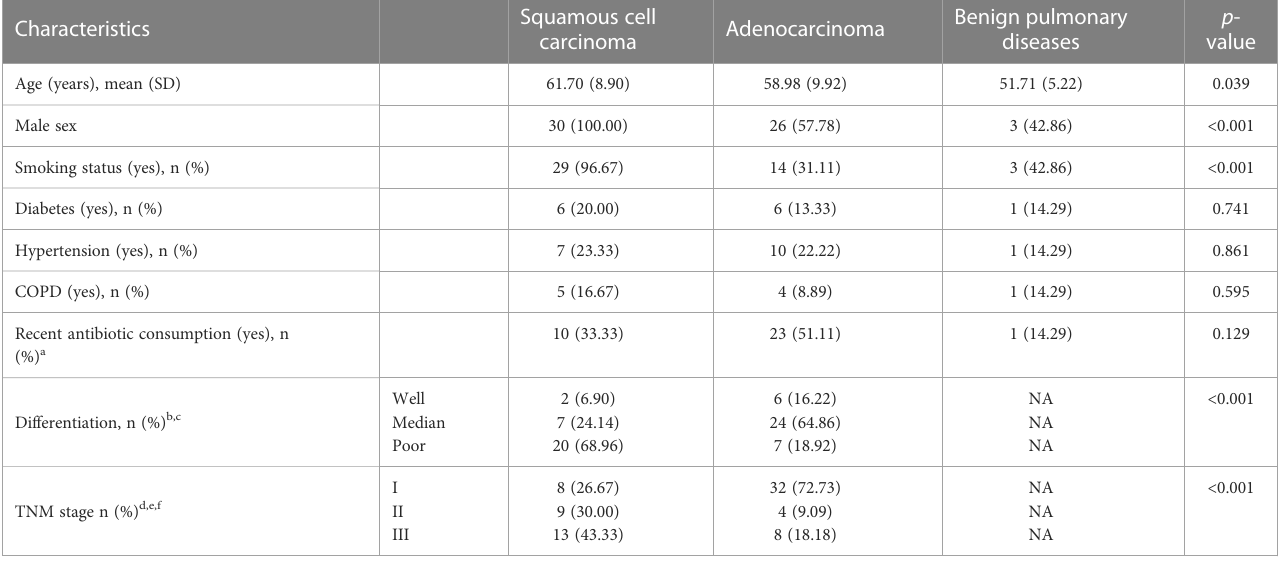
TABLE 1 Demographic and clinical characteristics of study participants.